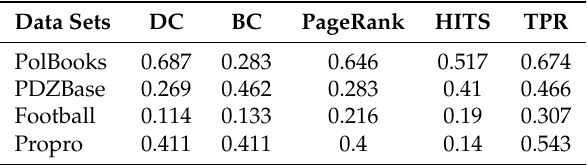
Table 6. Kendall correlation